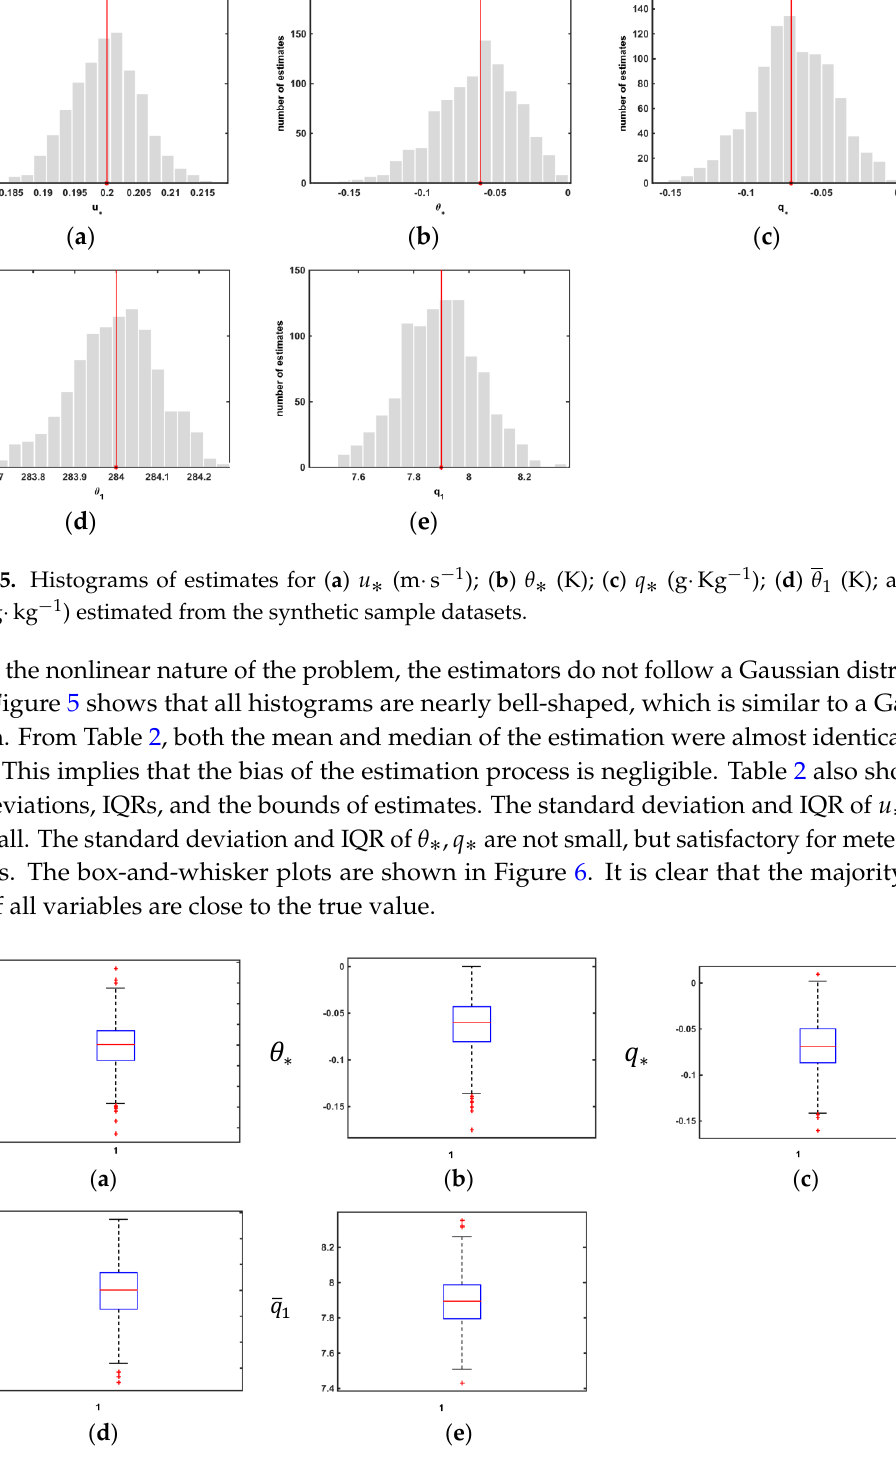
Figure 6. Box-and-whisker plots for ( a ) 𝑢 ∗ ; ( b ) 𝜃 ∗ ; ( c ) 𝑞 ∗ ; ( d ) 𝜃̅ 1 ; and ( e ) 𝑞̅ 1 showing the results based on 1000 sample datasets. Each plot shows the first and third quartile of the data, while the line in the center denotes the median. The two lines extending on either side of the box cover the data points within 2 × IQR and centered at the median. All remaining data points are shown as outliers. The unit for each variable is the same as in Figure 5.